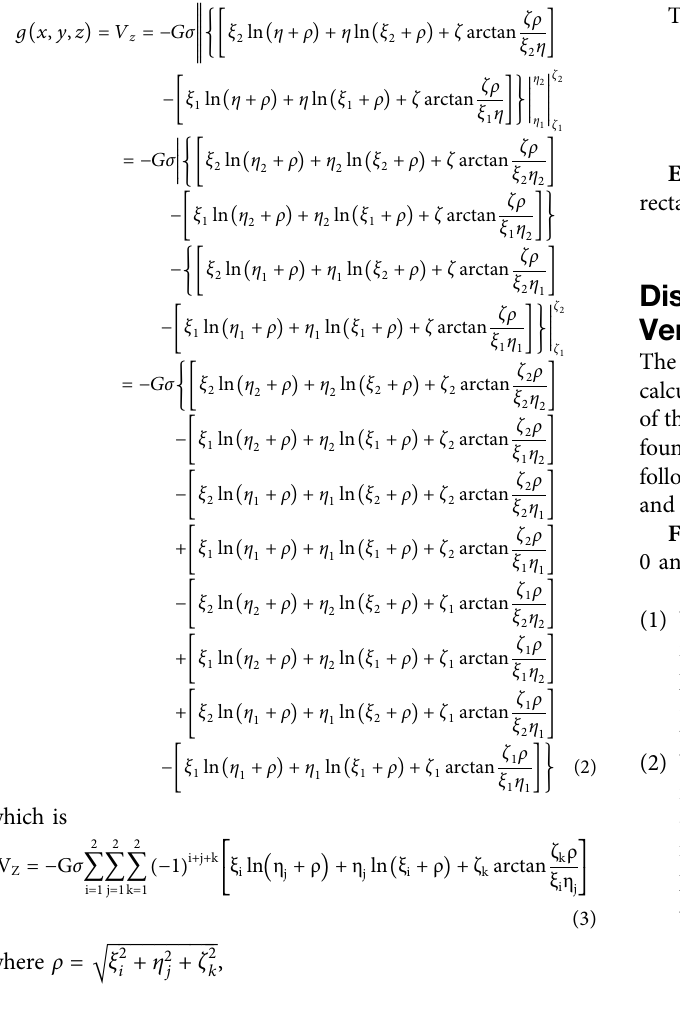
Frontiers in Earth Science |